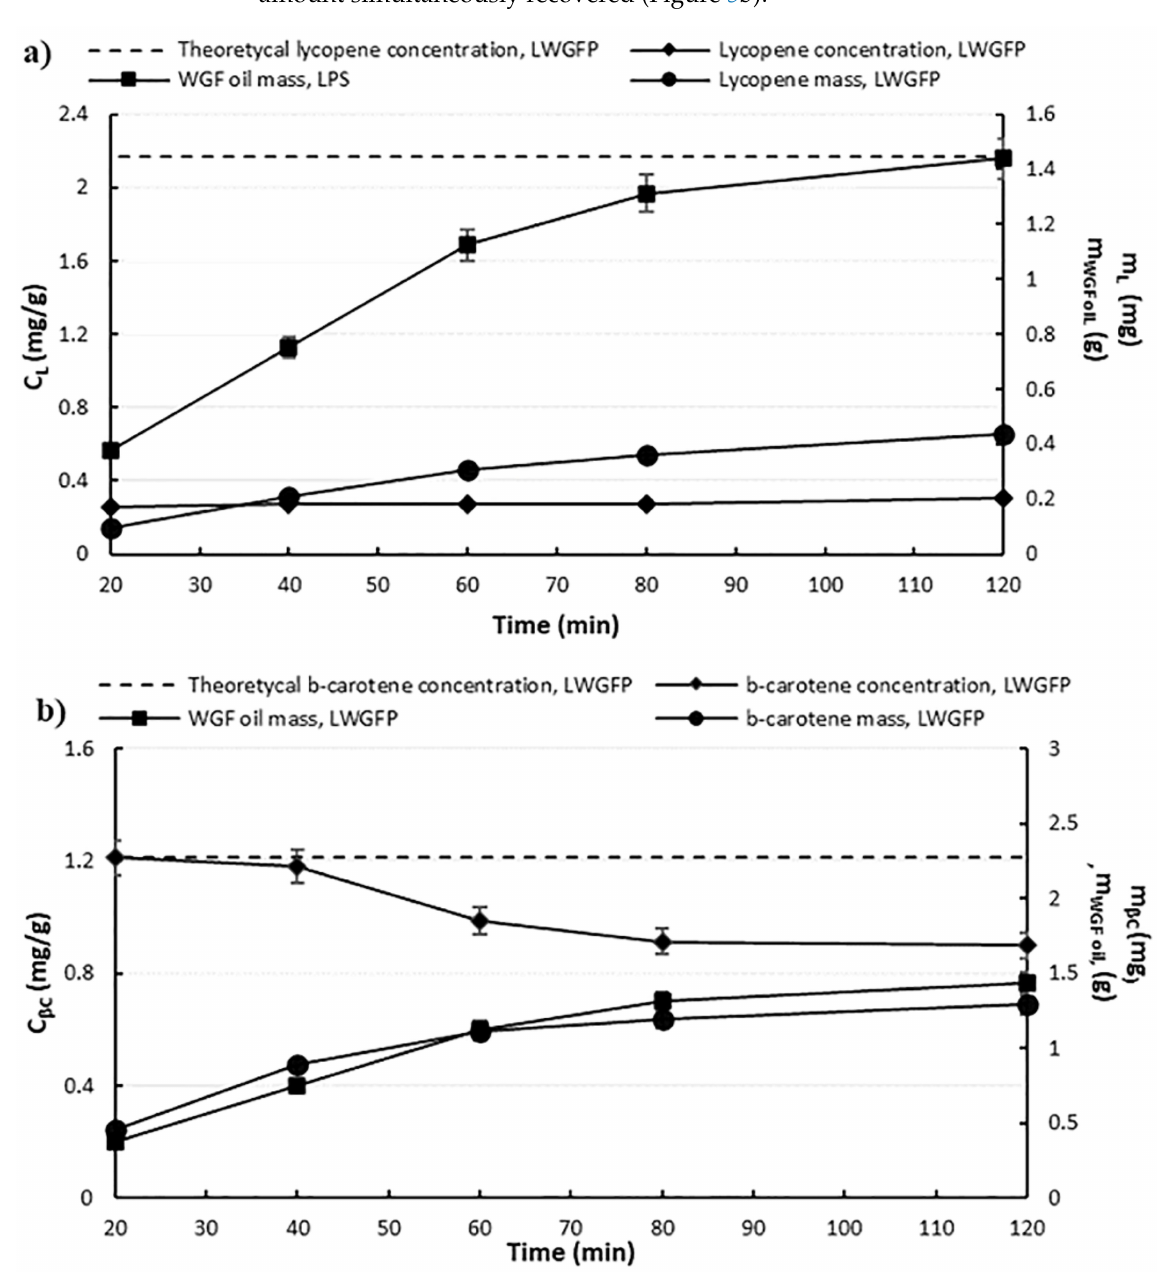
Figure 5. Lycopene ( a ) and β -carotene ( b ) concentrations in oil (C L and C β c, respectively), wheat germ flour oil mass (m WGF oil ), and carotenoid mass (m L and m β c for lycopene and β -carotene, respectively) evaluated during trial #7 with layered arrangement